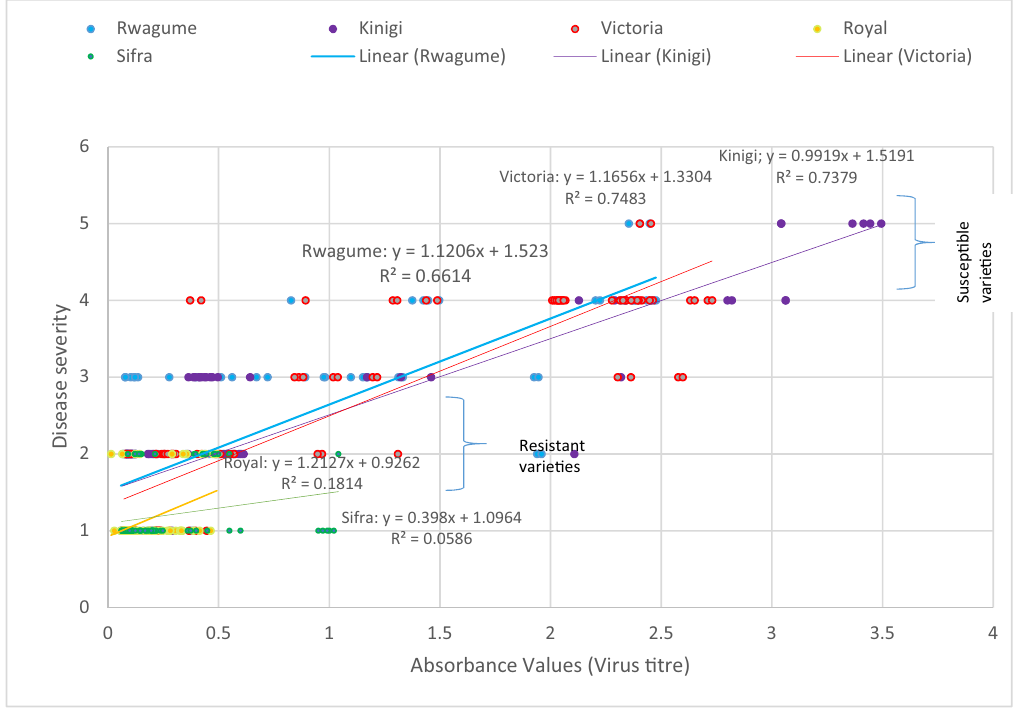
Figure 4: Relationship between the viral titer levels and disease severity for three susceptible and two potato - resistant